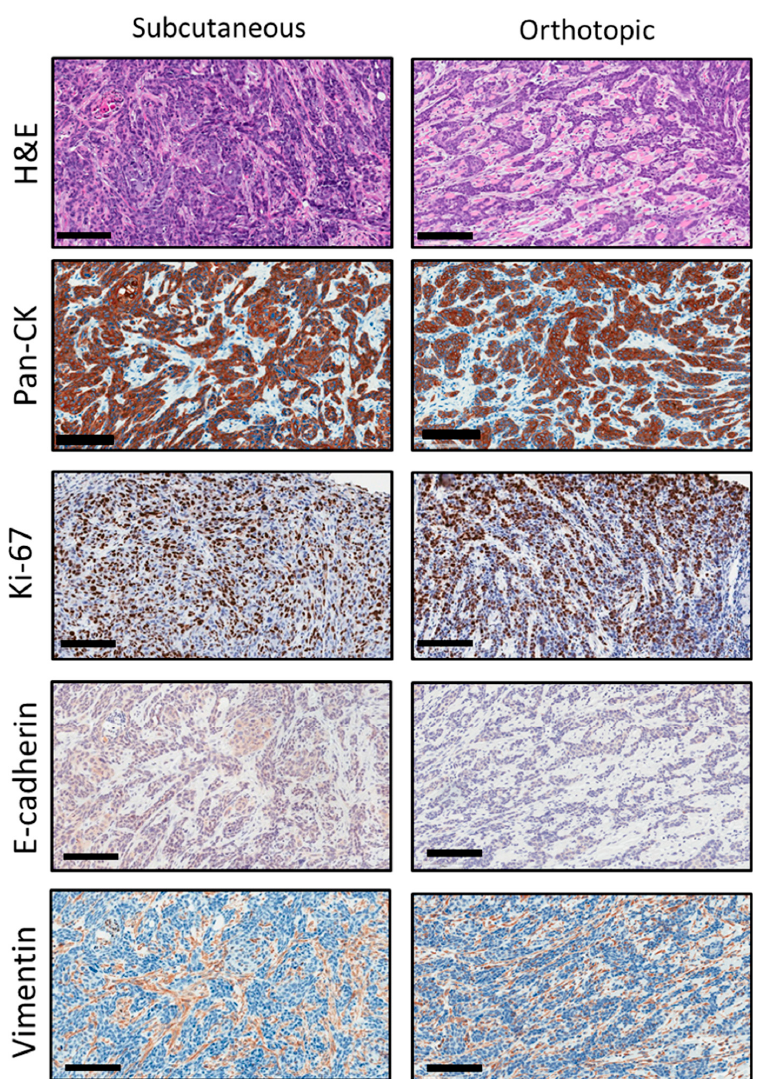
Figure 3. Histopathologic credentialing of RP-MOC1 tumors. Photomicrographs of histology and immunohistochemical staining of tumor sections from the initial subcutaneous tumor and the subsequent orthotopic tumor are shown. Hematoxylin and eosin (H&E) stained sections showed invasive keratinizing moderately differentiated squamous cell carcinoma. Image was acquired at 20× magnification. Scale bar: 100 μ m. Immunostaining for cytokeratin (Pan-CK) and Ki-67 showed positive staining on the membrane and nuclear staining of the epithelial cells. Immunostaining for E-cadherin and vimentin showed negative staining on the membrane and cytoplasm stain of the epithelial cells. Images were acquired at 20× magnification. Scale bar: 100 μ m.